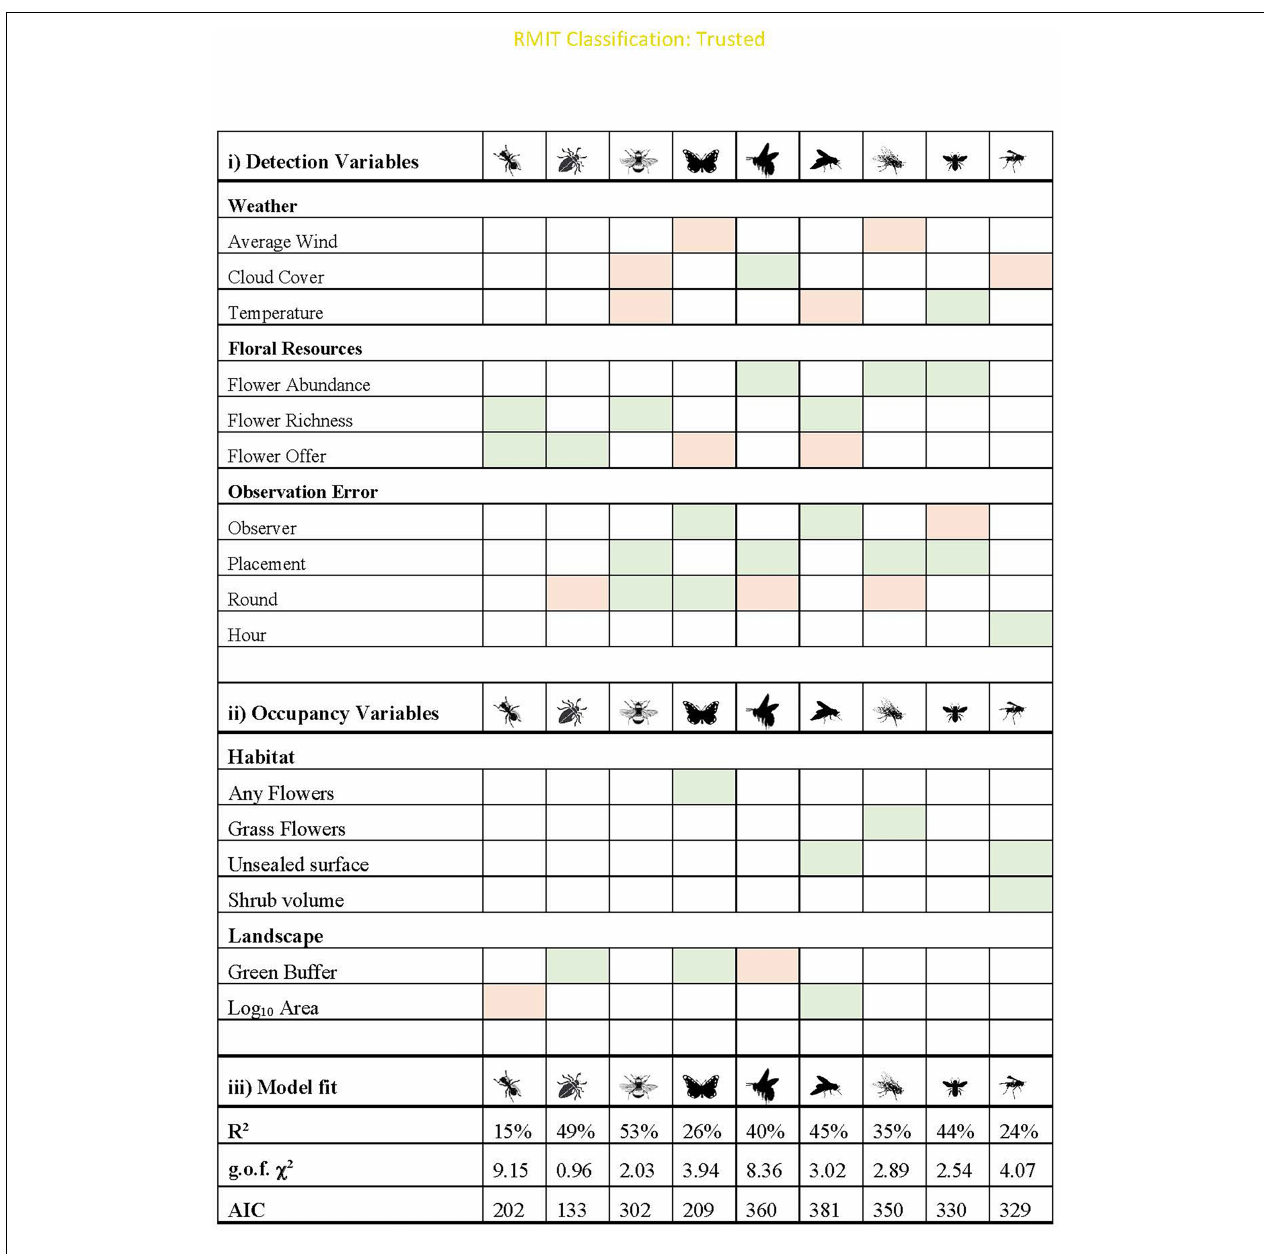
FIGURE 4 | Main effects and model fit for the final models for each functional group. All models assume additive effects, and shading indicates whether the relationship is positive (green) or negative (orange). All models passed the g.o.f. test ( p > 0.05). Cloud cover: the relationship is “negative” if there was higher detection on sunny days. Observer: positive indicates that more experienced surveyors were more likely to detect interactions. Placement: positive relationship indicates the taxa was more likely to be detected on unsealed surfaces. Round was shaded as negative if the detection probability decreased after the first round. Further graphs are in Supplementary Figures 1, 2